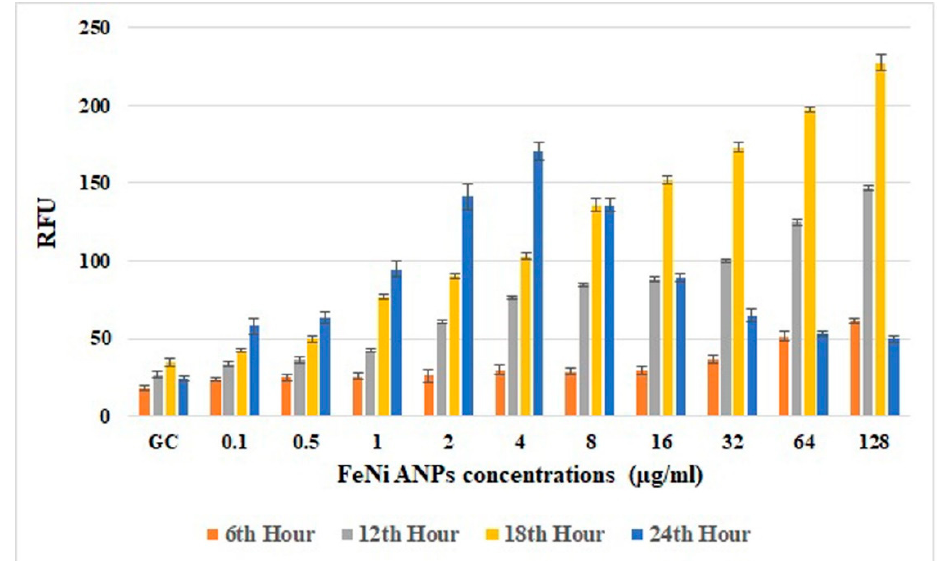
Figure 8. Results of intracellular ROS assay. RFU: relative fluorescence unit.